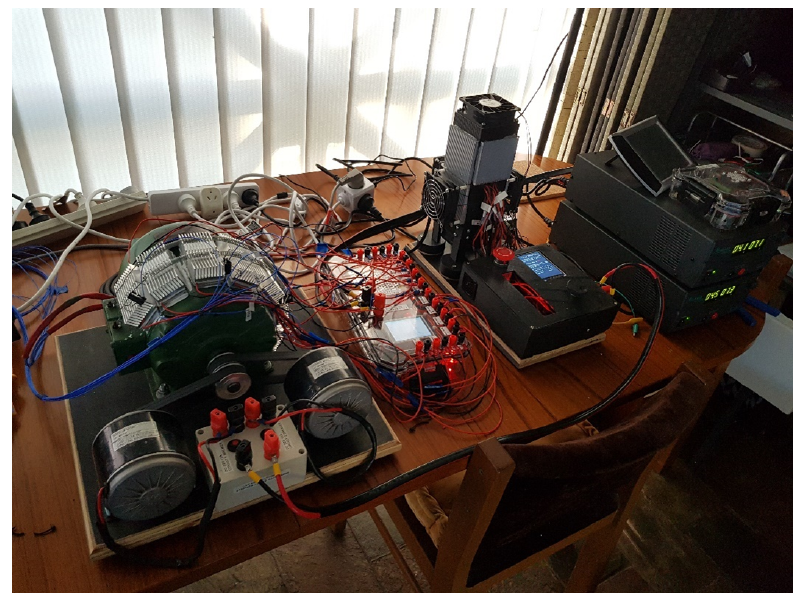
Figure 9. The setup of the heating of the test motor with the TECs and small heat sinks.